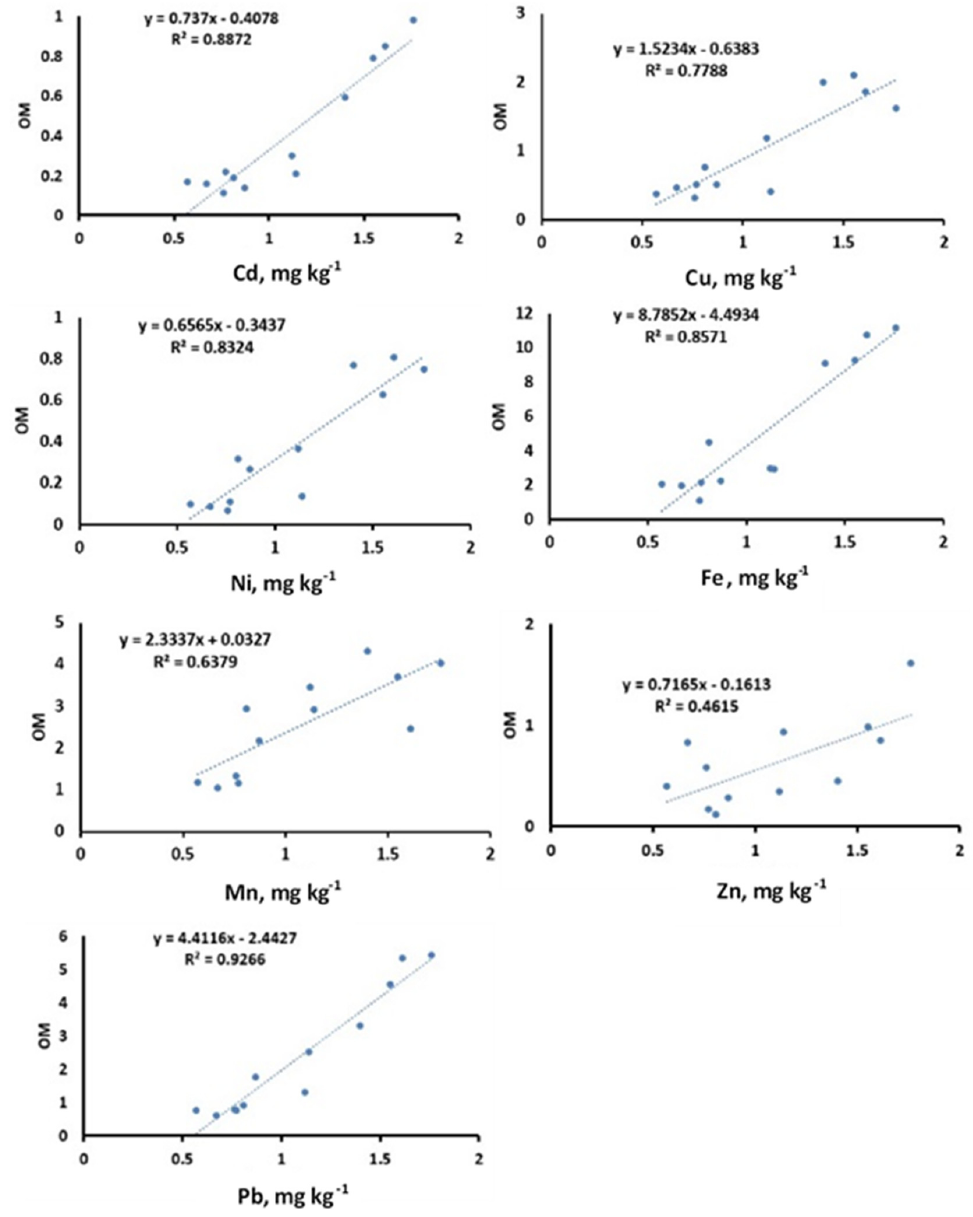
Figure 2. Relationships between soil organic matter content and soil pollution in the studied soil profiles. The different soil textures in the study area can be classified as clay, sandy clay loam, clay loam, and silt clay loam, with a dominance of clayey grade. Figure 3 shows the verti- cal distribution of clay, silt, and sand, by percentage, through the three studied horizons of the different profiles (0–30, 30–60, and 60–90 cm). Clayey soils irrigated by wastewater (for instance, profile No. 11 has a clay texture, with 62.09% clay content) have a higher total content of heavy metals than sandy soils (for instance, profile No. 6 has a sandy clay loam texture, with 51% total sand content) when irrigated by the same water source (Fig- ure 3 and Table 2).